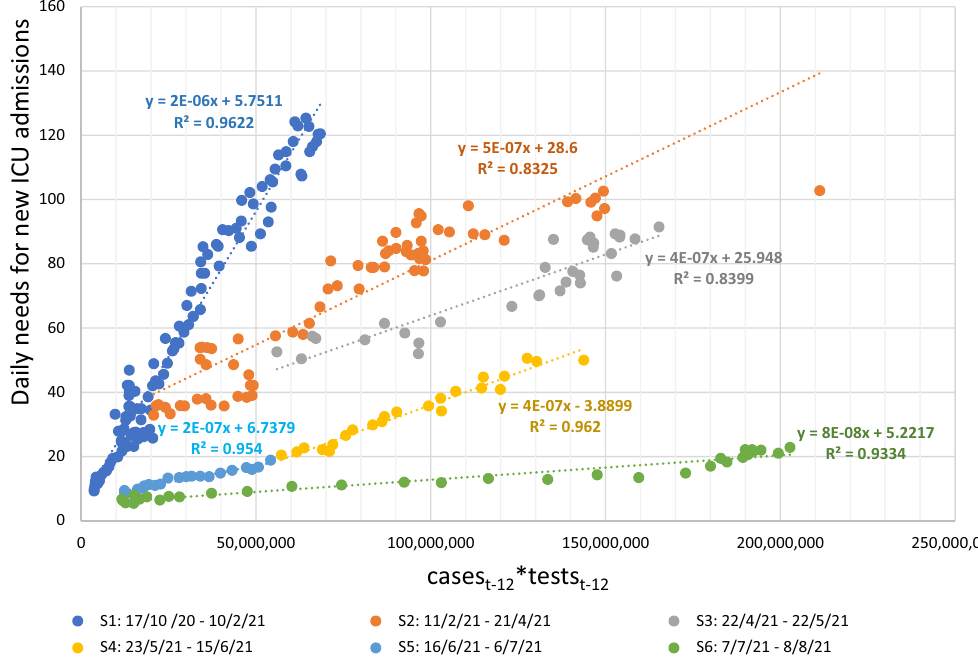
Figure 3. Correlation of the numerator and denominator of SDR, i.e., number U versus the product